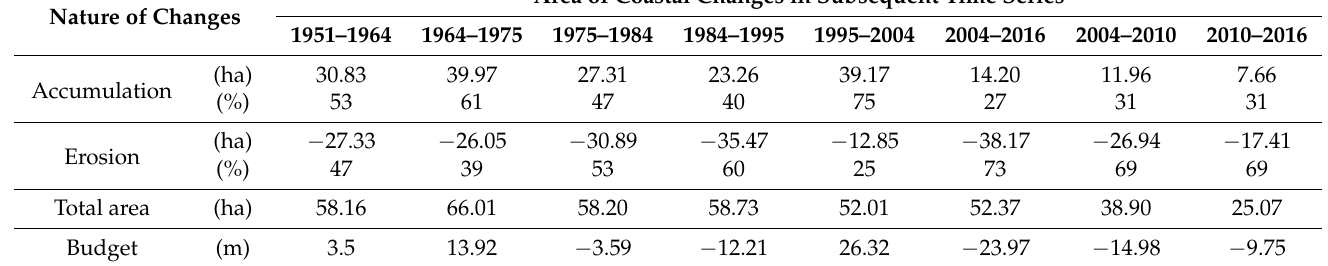
Table 3. Area of coastal changes in subsequent time series: value of accumulated and eroded area, total area of changes, and the balance of the impact of morphodynamic processes on the studied part of the